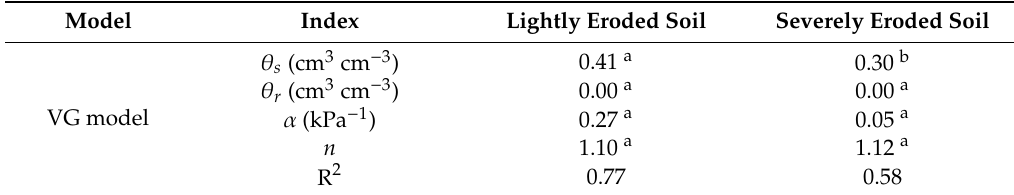
Table 4. The parameters of the VG model for di ff erent erosion soils. Model